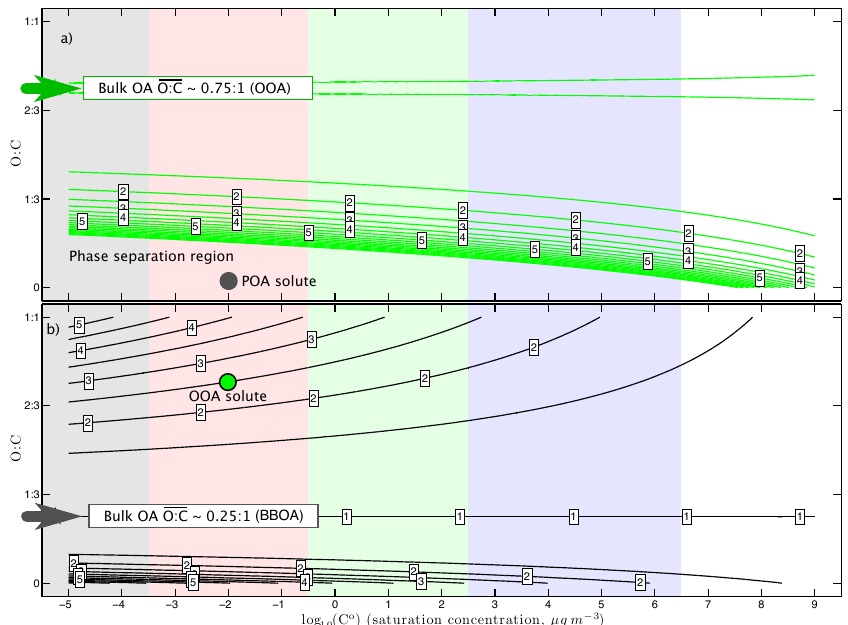
Fig. 6. Activity coefficients of organics in the 2-D space for two different mean OA compositions. In panel (a) the mean O:C of the bulk OA is 0.75:1 (OOA-like), indicated by the thick green arrow, while in panel (b) the mean O:C in the bulk OA is 0.25:1 (biomass burning, or BBOA-like), indicated by the thick gray arrow. The isopleths are for γ i,s , the activity coefficient of organics with the log 10 C o and O:C indicated in each solution. Contours are steps of 0.5 in γ , starting at 1 and ending at 10. Integer values are labeled up to γ = 5. Somewhere between 5 <γ < 10 phase separation becomes very likely. For example, the POA constituent indicated by the dark gray circle in panel (a) at log 10 C o = − 2, O:C = 0:0 has an activity coefficient in the bulk OOA (cid:29) 10; conversely, the OOA constituent indicated by the green circle in in bottom panel at log 10 C o =− 2, O:C = 0.75:1 has an activity coefficient in the bulk BBOA = 2 .